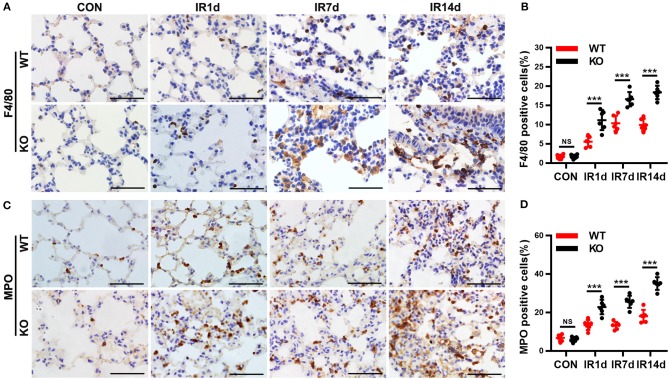
Nrf2 deficiency exacerbates radiation-induced infiltration of macrophages and neutrophils in lung tissues. (A,B) Immunohistochemistry staining of F4/80, a biomarker of macrophages, in lung tissues from the 8 groups of mice. Nrf2 knockout increased radiation-induced infiltration of macrophages. Scale bar: 50 μm. (C,D) Immunohistochemistry staining of MPO, a biomarker of neutrophils, in lung tissues of mice. Loss of Nrf2 contributed to radiation-induced infiltration of neutrophils. Scale bar: 50 μm. n = 6. NSRepresents no statistical difference (P > 0.05). ***P < 0.001. The data was shown as mean ± SD. The representative figures of 3 independent experiments were presented here.